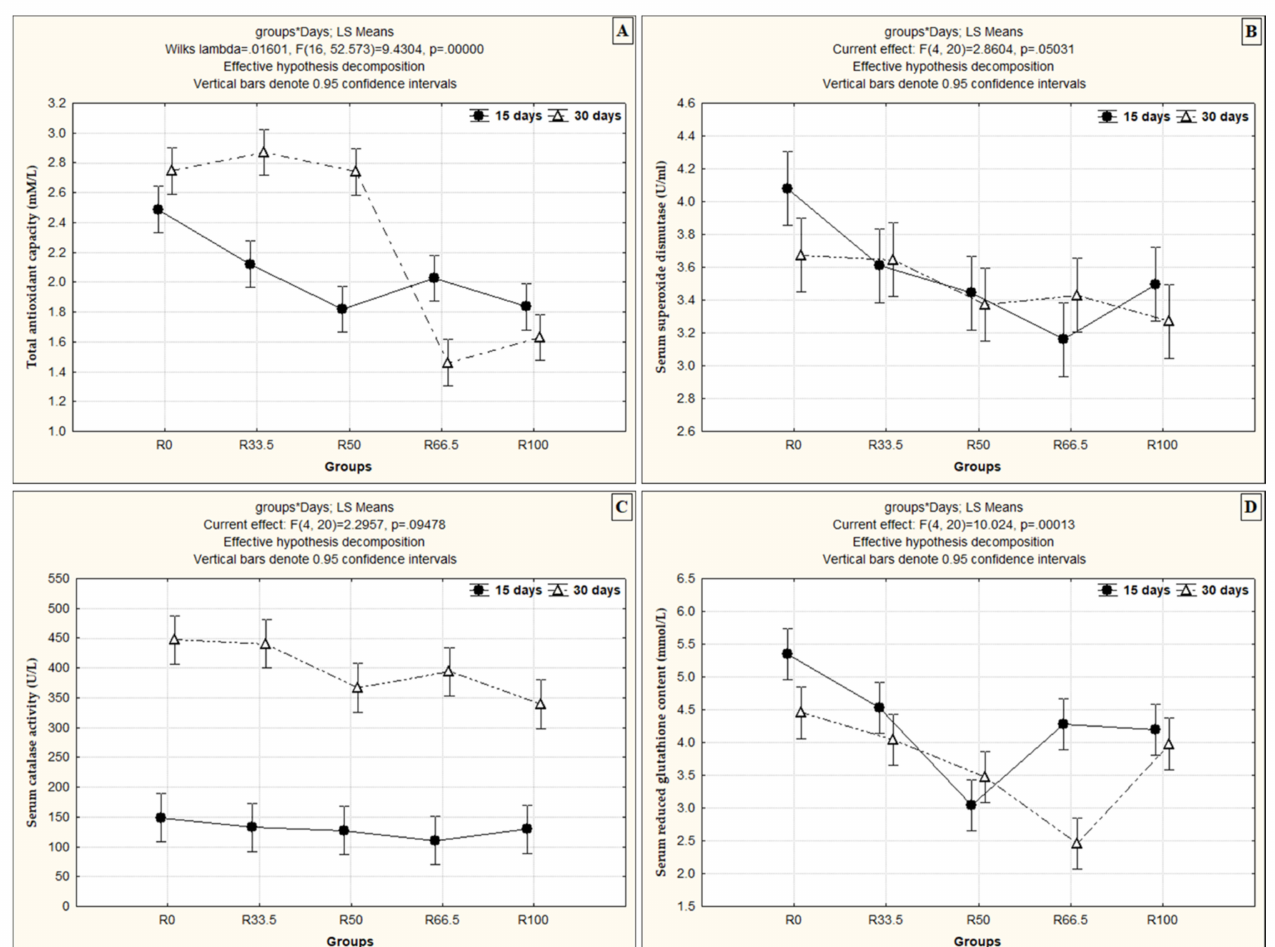
Figure 2. The interaction effect between the levels of fishmeal substitution with plant protein (soybean and sunflower meal) and feeding duration on ( A ) total antioxidant capacity (mM/L), ( B ) serum superoxide dismutase (U/mL), ( C ) serum catalase activity (U/L) and ( D ) serum reduced glutathione content (mmol/L). R0, R33.5, R50, R66.5 and R100: see legend of Figure